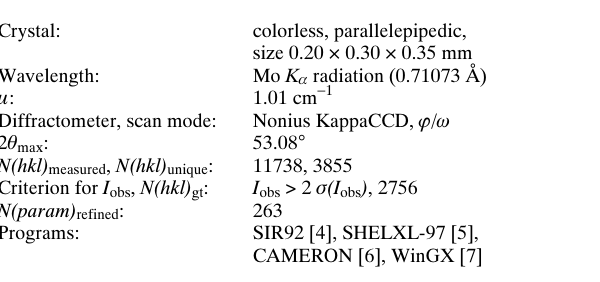
Table 1. Data collection and handling.